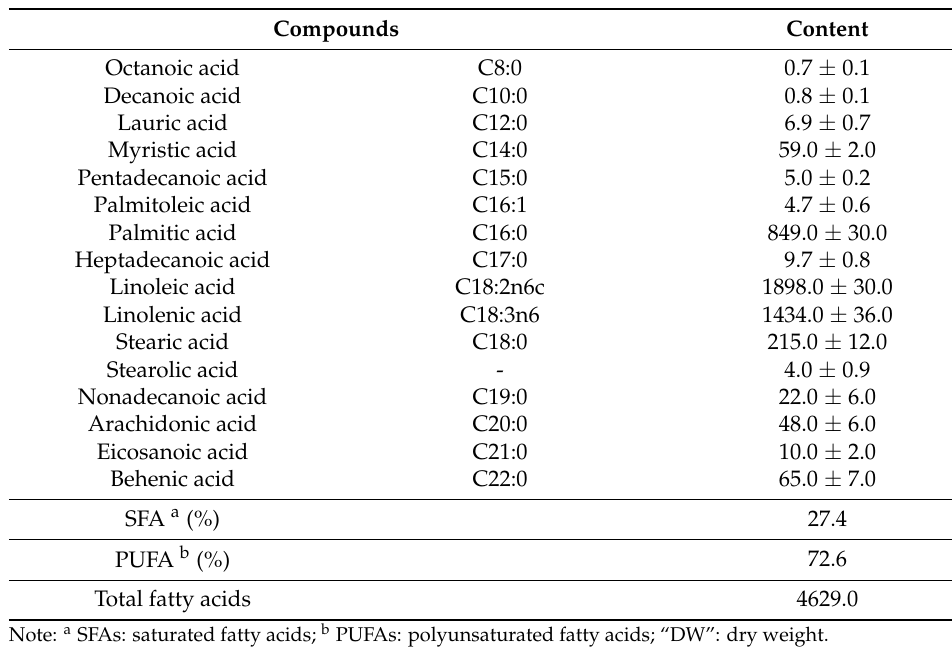
Table 3. Fatty acid composition and content analysis of Gonostegia hirta ( µ g/g DW).